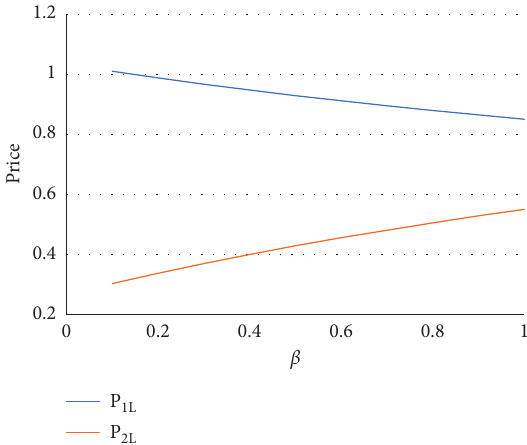
Figure 3: The influence of parameter β on product price.